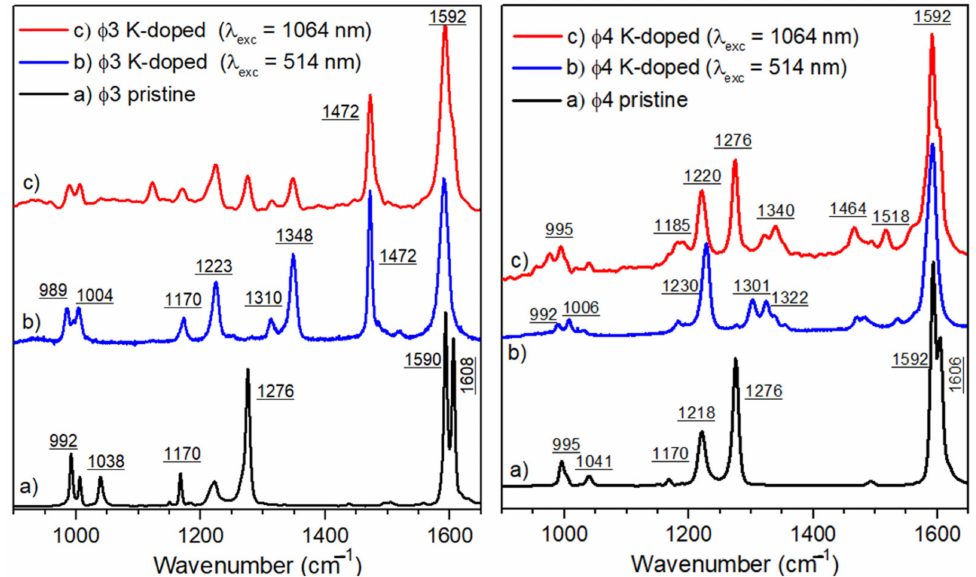
Figure 6. The Raman spectra of p -terphenyl ( left ) and p -quaterphenyl ( right ) is registered in the pristine ( a ) and reduced format 514.5 nm ( b ) and 1064 nm ( c ) excitation